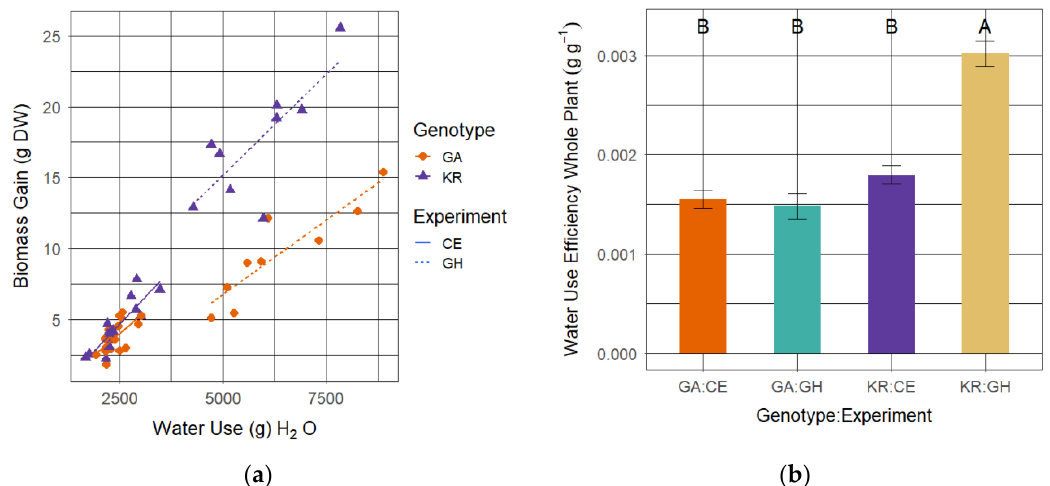
Figure 1. The relationship between aboveground biomass gain and water use determined by: ( a ) the linear relationship (BM ~ WU) between biomass gain (BM) and water consumption (WU), where each point is a single biological replicate ( R 2 = 0.94, p < 0.001) and ( b ) whole plant water use efficiency ( WUE wp ) across two experiments (CE, Controlled environment; GH, Glasshouse) and two wheat cultivars (KR, Krichauff; GA, Gatsby), where values represent means ± SE of 6 biological replicates.